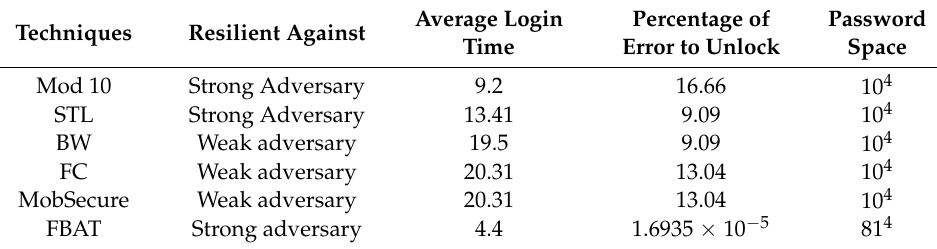
Table 6. Comparative analysis of Mod 10, STL, BW, FC and MobSecure with